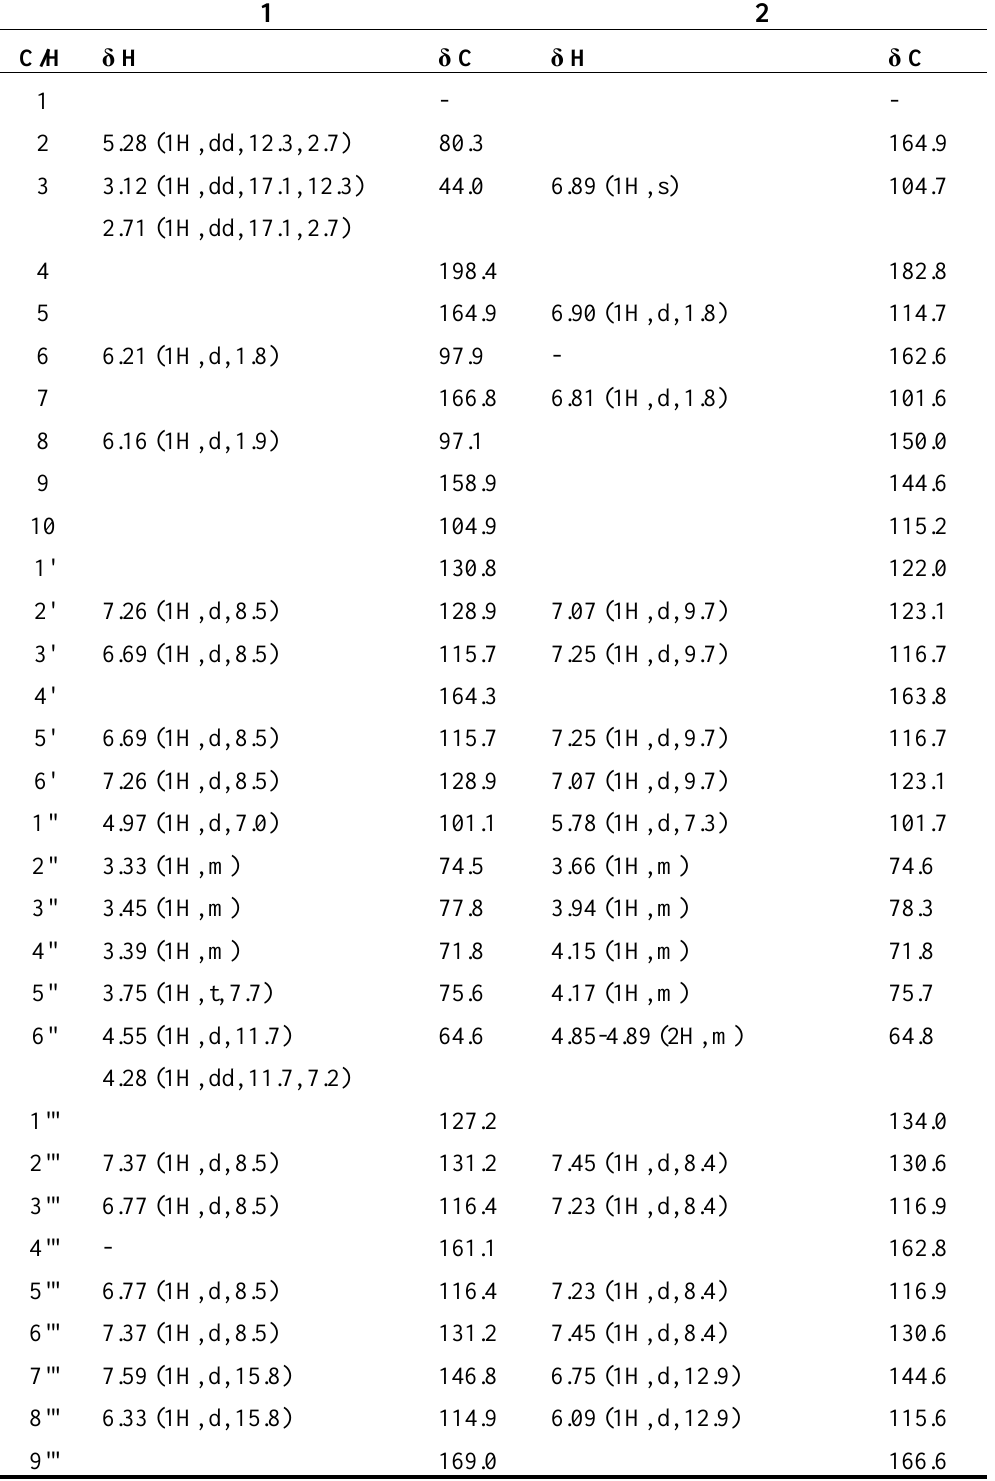
OD) for leufolins A ( 1 ) and B ( 2 3